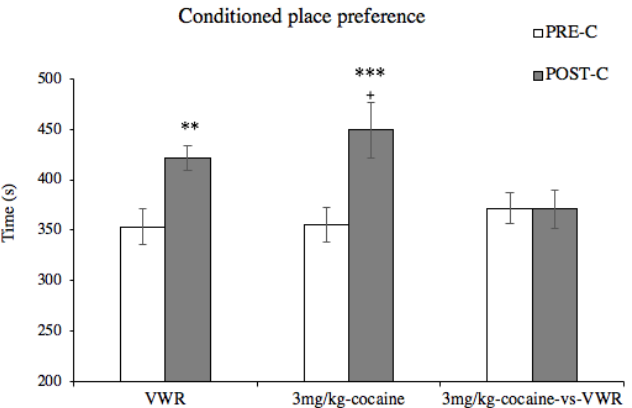
Figure 10. Voluntary wheel running induced CPP and neutralized the development of a preference for an effective dose of cocaine (3 mg/kg). The bars represent the time (s) spent in the active-wheel- paired compartment (VWR group) or in the cocaine-drug-paired compartment (3 mg/kg-cocaine and 3 mg/kg-cocaine-versus-VWR groups). White bars represent the time (s) spent during the Pre-C test and dark gray bars, after conditioning sessions in the Post-C test; ** p < 0.01; *** p <0.001 significant difference in the time spent in the paired compartment with respect Pre-C; + p < 0.05 differences in the time spent during the Post-C between the groups of 3 mg/kg cocaine and 3 mg/kg cocaine vs. VWR.